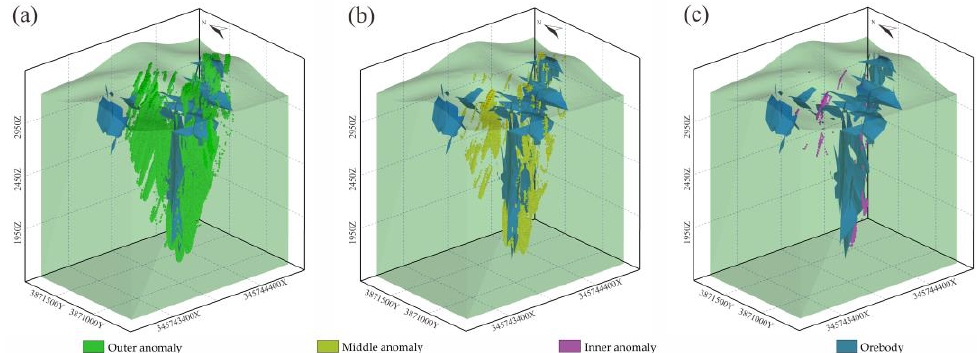
Figure 7. Three-dimensional model of Au anomaly data volume in Zaozigou gold deposit. ( a ) outer anomalies of Au. ( b ) Middle anomalies of Au. ( c ) Inner anomalies of Au. The middle and inner anomalies are mainly distributed inside and around the orebody, which accurately reflects the spatial spreading of the orebody and its trend. On this basis, this study analyzed and visualized the 3D anomalous structures of the remaining 11 elements using the above model (Figure 8; Table 2).